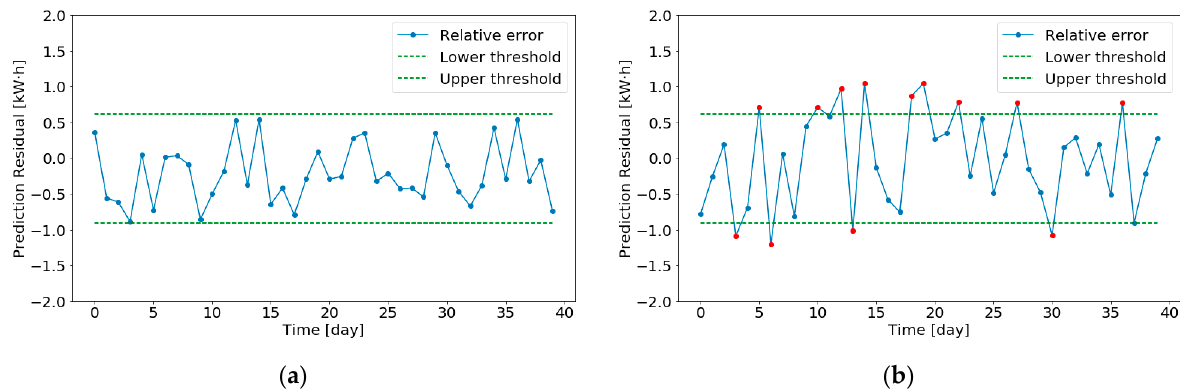
Figure 7. ( a ) State monitoring diagram of normal smart meter. ( b ) State monitoring diagram of smart meter after adding